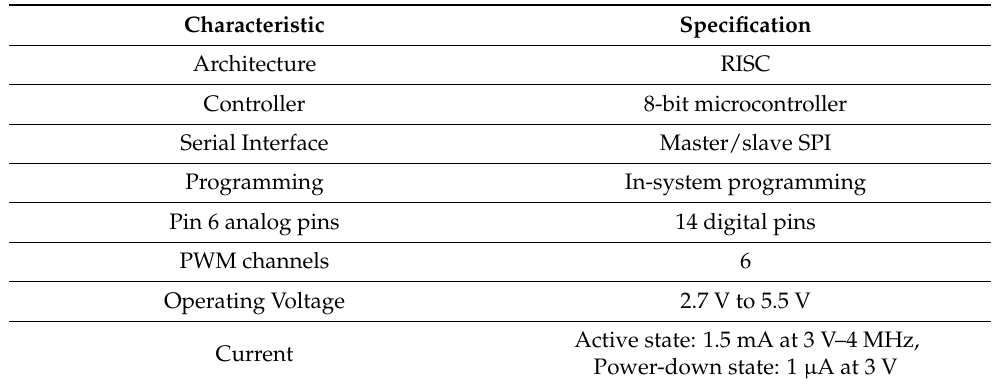
Table 3. ATmega328P specifications [32].